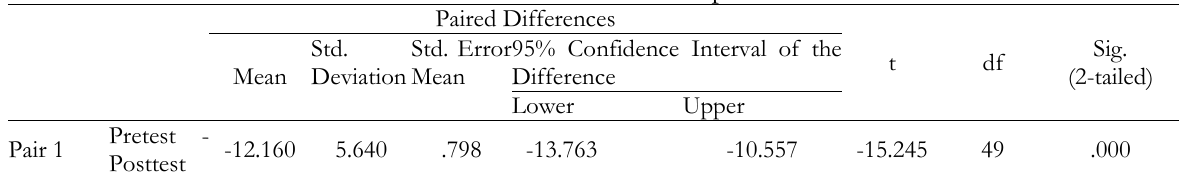
TABLE 5. Paired Samples Test Paired